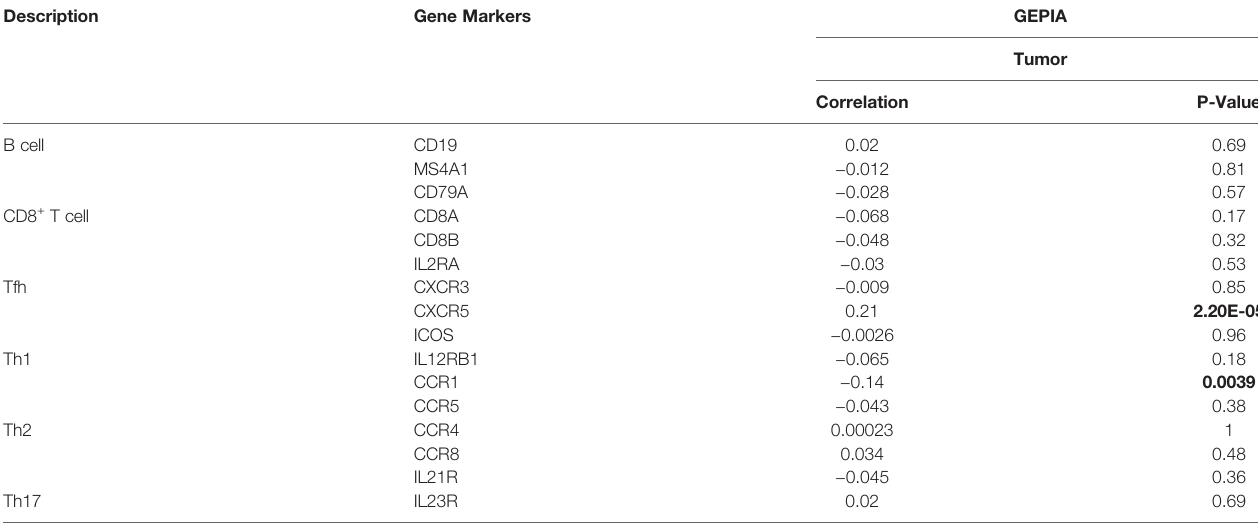
TABLE 3 | Correlation analysis between SLC17A9 and immune cell marker gene in GEPIA